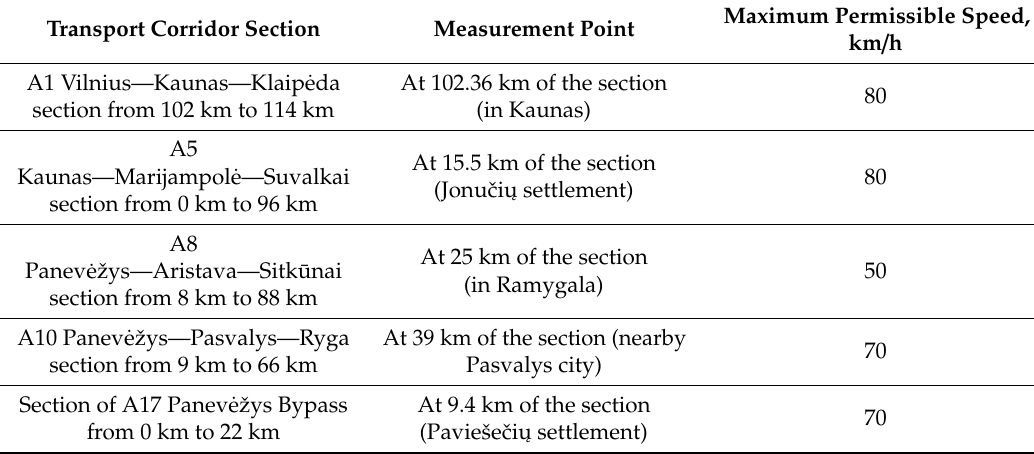
Table 1. Noise measurement points in Via Baltica transport logistics